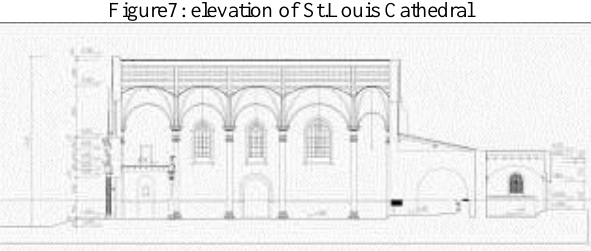
Figure7: elevation of St.Louis Cathedral